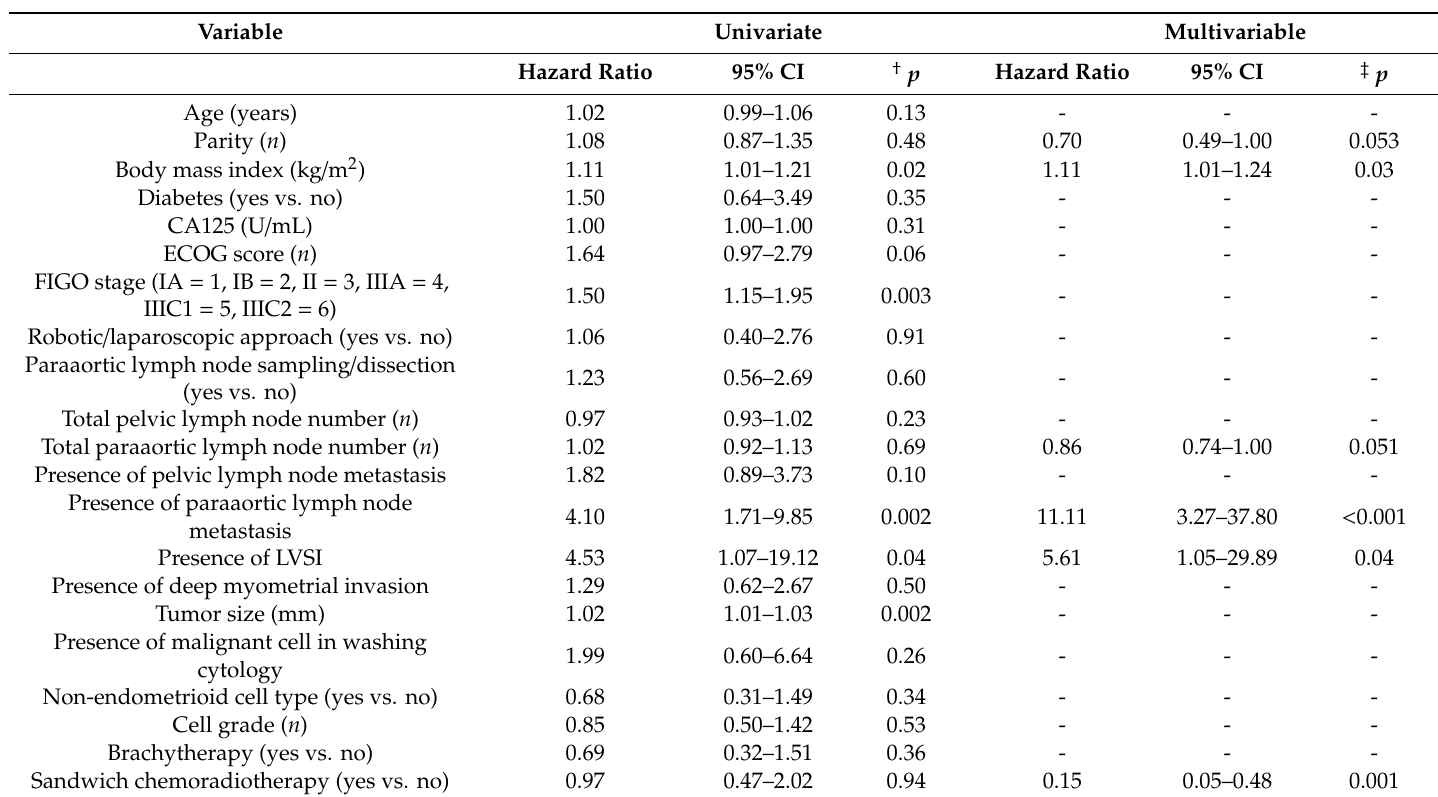
Table 3. Univariate and multivariable Cox proportional-hazards model for predicting progression free survival after adjuvant therapy for women with high risk endometrial cancer ( n = 92).